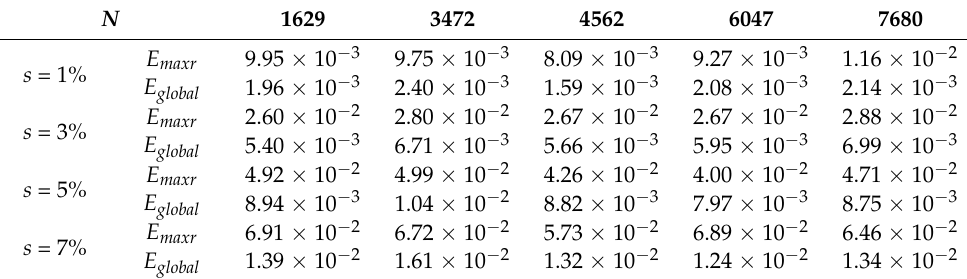
Table 7. The numerical errors with different number of local